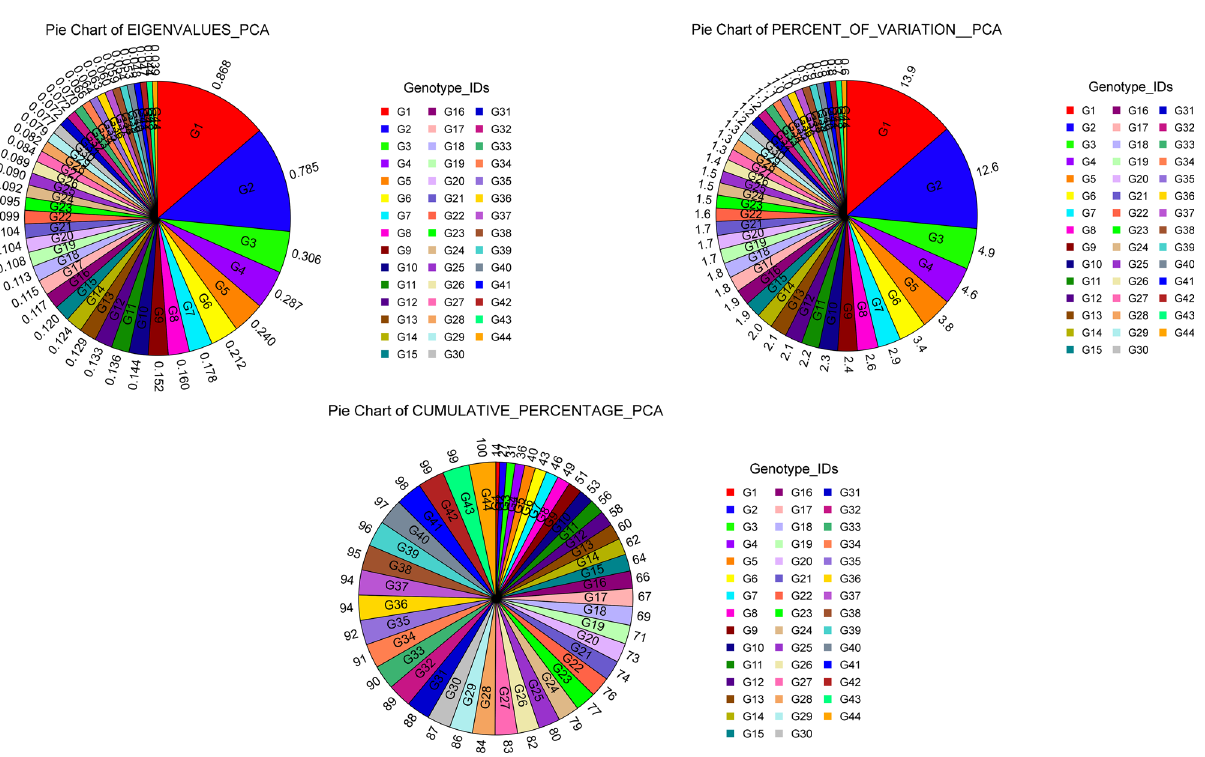
Figure 6. Pie chart showing the eigenvalues, % of variation and cumulative % of variation of 44 axis or PCs revealed by PCA analysis using NCSS